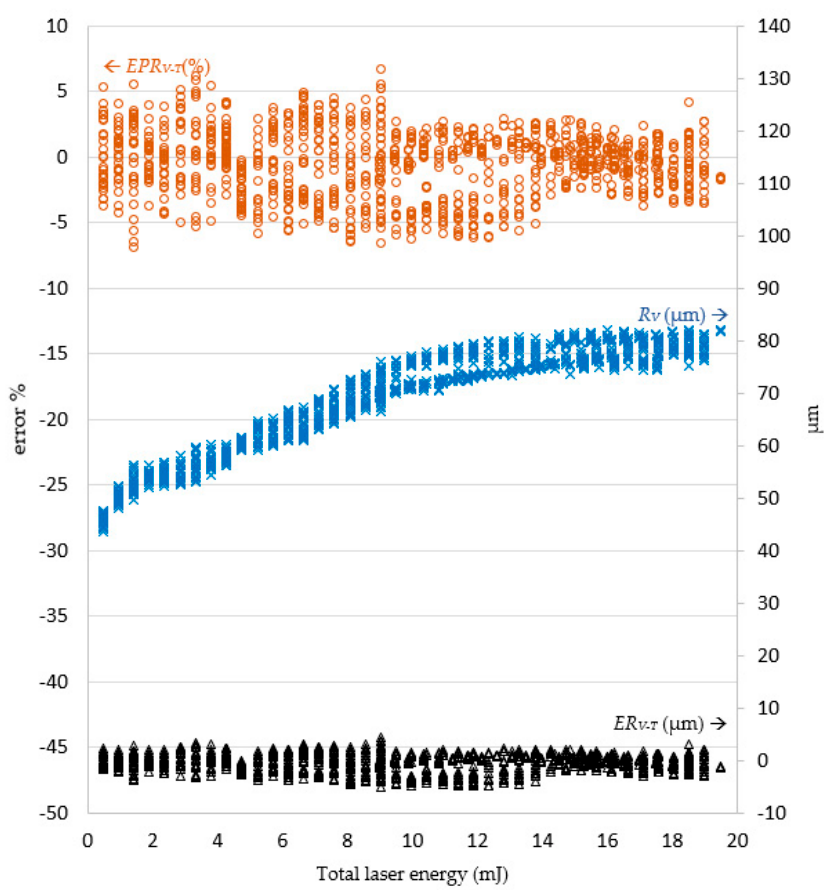
Micromachines 2022 , 13 , x FOR PEER REVIEW Figure 9. The error ER V − T between the target and actual hole diameter ( R T and R V ) corresponds to the total laser energy. Note: ER V − T = R V − R T ; EPR V − T = ( R V − R T )/ R T (%). Table 5. Average error of training and testing for the LPPM.